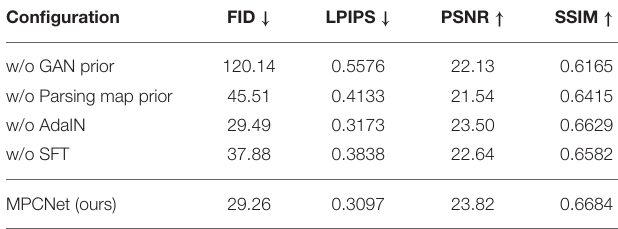
TABLE 2 | The quantitative performance of different variants on CelebA-Test. TABLE 3 | Quantitative comparison on CelebA-Test for blind face restoration